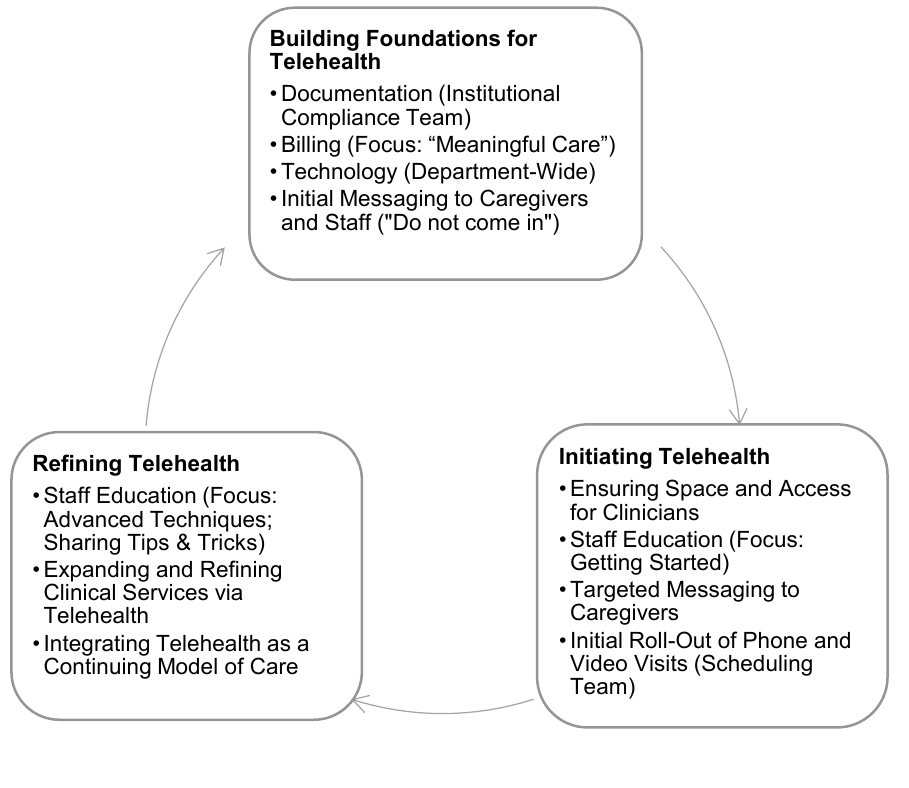
Model for Rapid Clinical Implementation of Telerehabilitation that Includes Three Phases: Building Foundations for Telehealth, Initiating Telehealth, and Refining